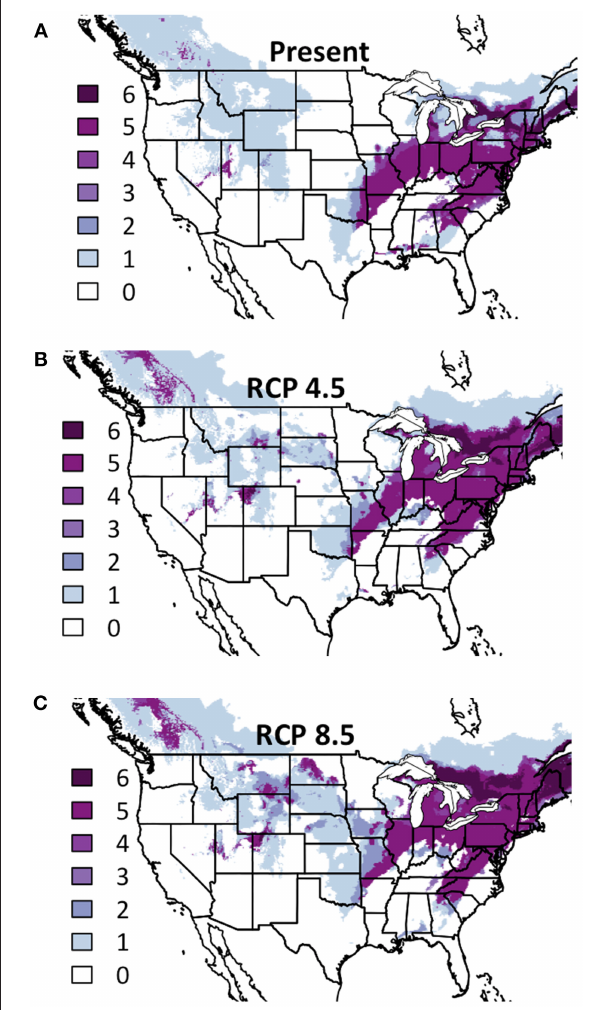
FIGURE 2 | Composite Map of Warm-Season Grass (A) Current Distribution and Response to (B) RCP 4.5 and (C) RCP 8.5. Colors indicate the number of species where suitability is predicted to ≥ 50%. Darker colors indicate areas where bioclimatic suitability is above the threshold for more species. Included species are Bouteloua curtipendula , Schizachyrium scoparium , and Sorghastrum nutans . Time period is identified in the top of each panel.